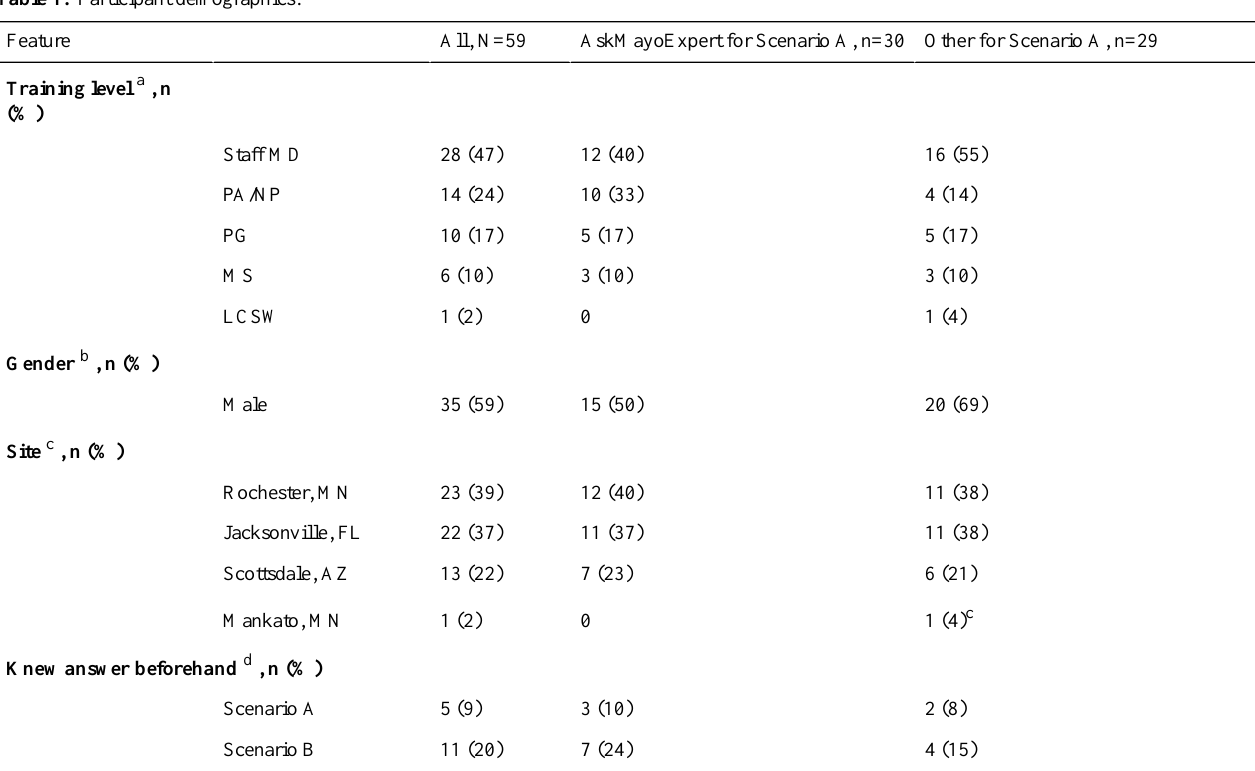
Other for Scenario A, n=29AskMayoExpert for Scenario A, n=30All, N=59Feature